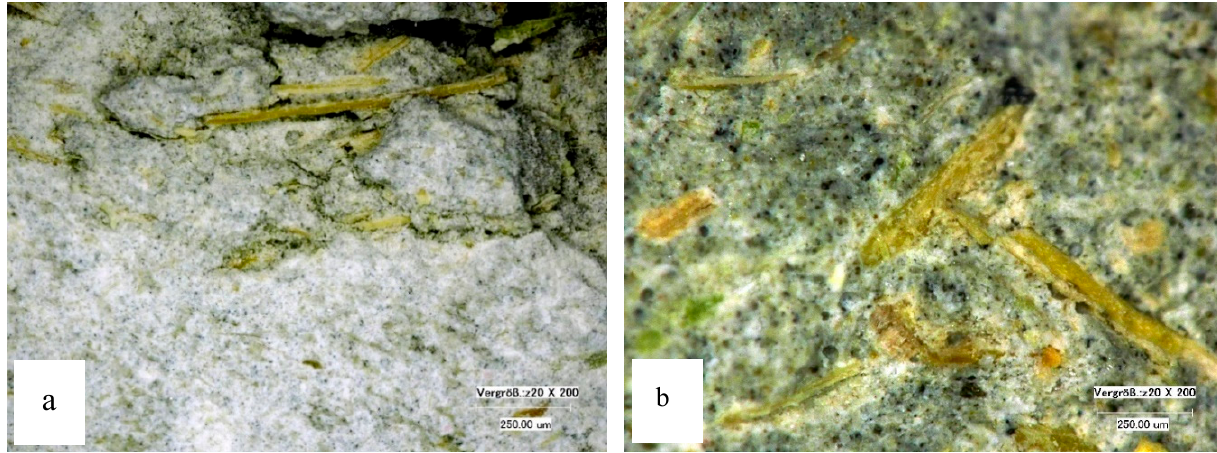
Figure 10. Optical microscopic morphology of concrete fracture surface at 15%wt. rice straw: ( a ) un-treated straw, and ( b ) NaOH-treated straw.